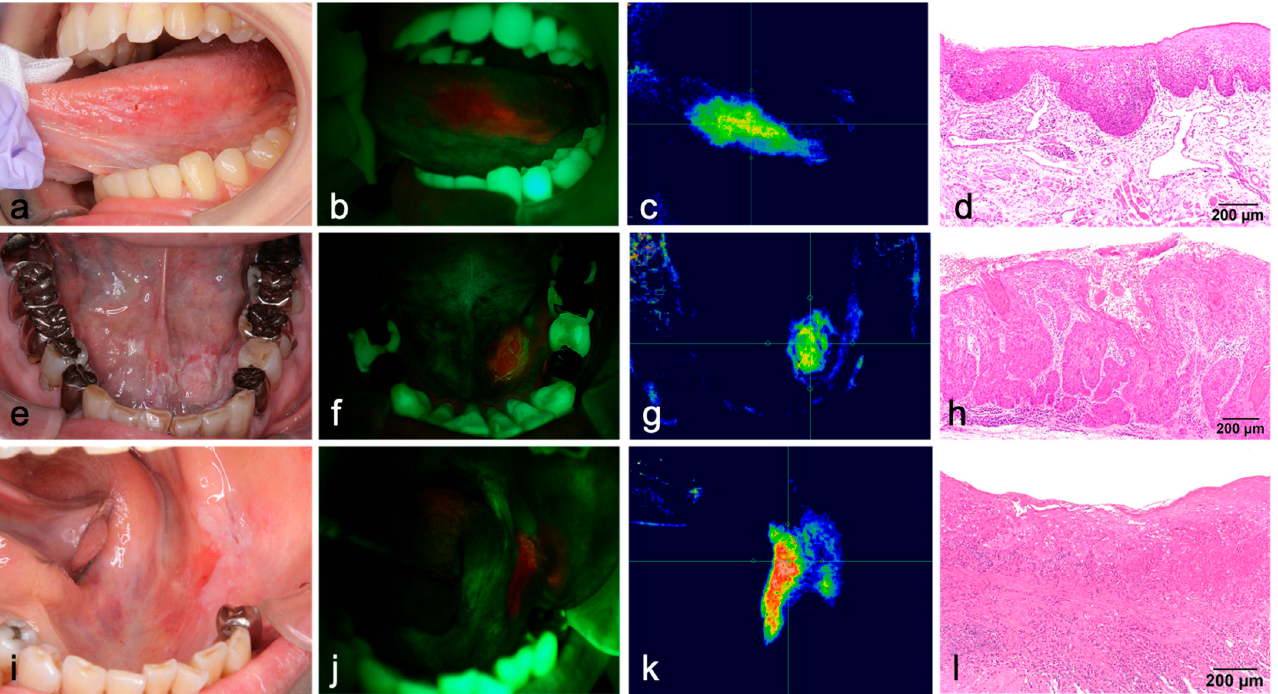
Figure 3. Oral findings, fluorescent images, and chromaticity of the oral lesions. ( a – d ) Severe OED of the tongue. ( e – h ) Early oral squamous cell carcinoma (OSCC) and mild OED of the oral floor. ( i – l ) Early OSCC of the mandibular gingiva. ( b , f , j ) Fluorescent images using ALA-PDD visualized these lesions as red fluorescence. ( c , g , k ) Converted images were used to extract redness. ( d , h , l ) histopathological findings (hematoxylin and eosin staining).